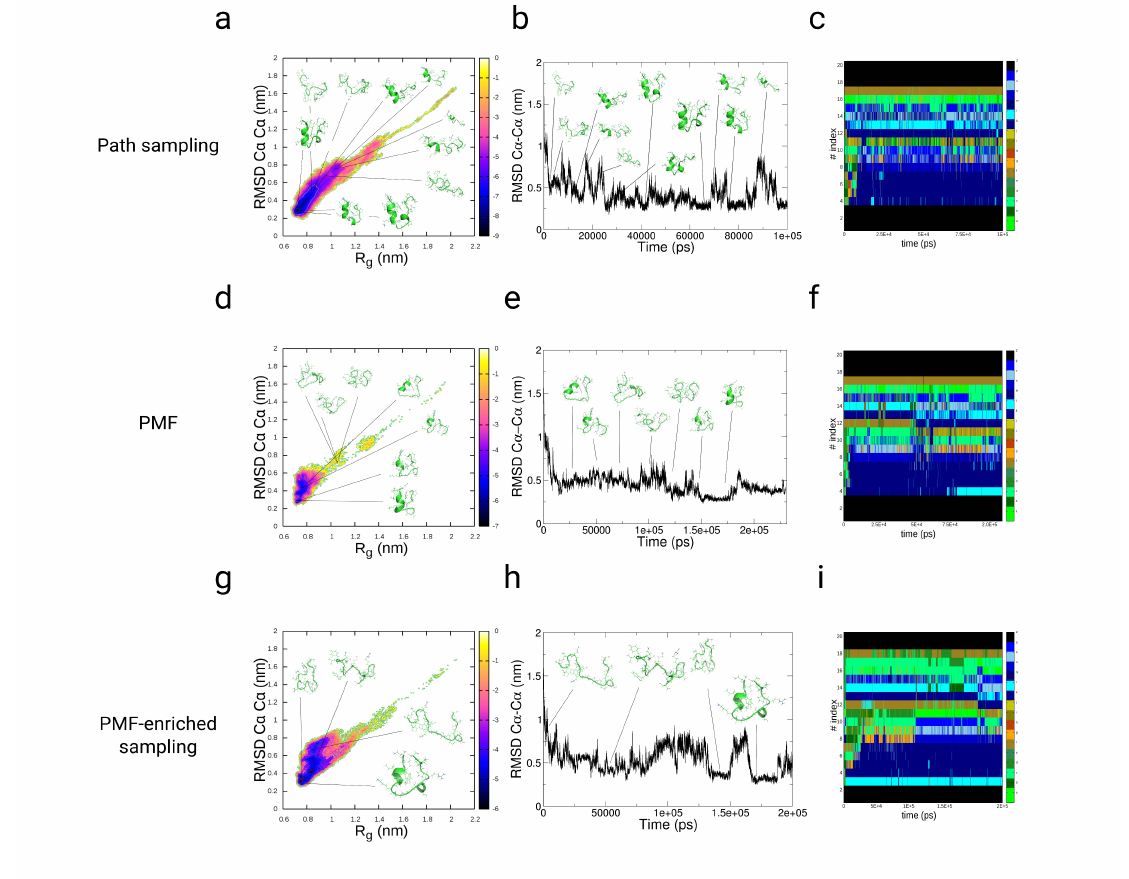
Figure 4. Results from adaptive path-sampling and PMF-enriched sampling simulations of TrpCage [73]. (Results from path-sampling ( a – c ), the direct application of p-PMFs without partitions Ω ( r ij ) and Ω ( θ ) ( d – f ), and PMF-enriched sampling ( g – i )). We started the simulation from an extended k